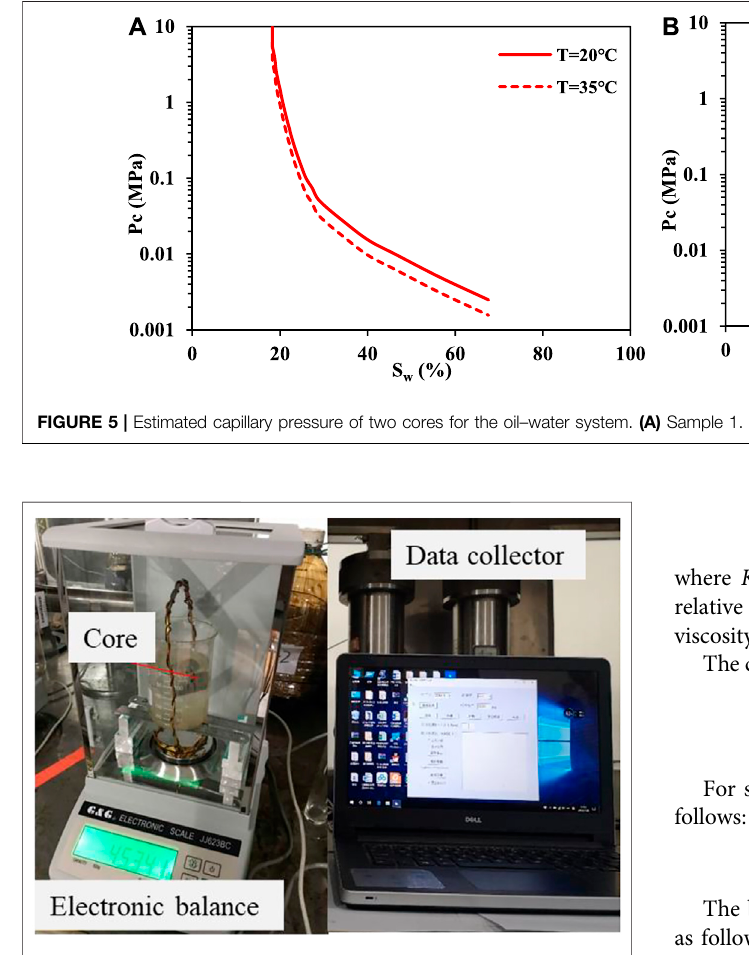
FIGURE 6 | Picture of spontaneous imbibition